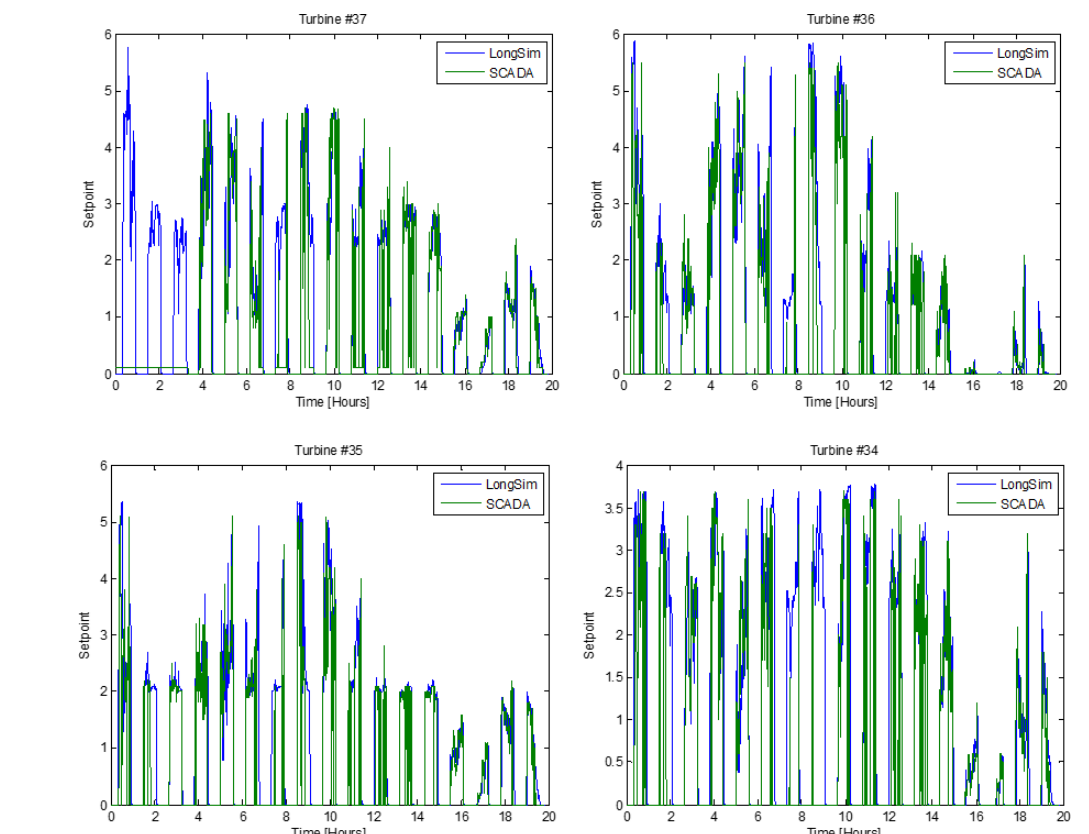
Figure 23. Measured and predicted setpoints at turbine nos. 37, 36, 35 and